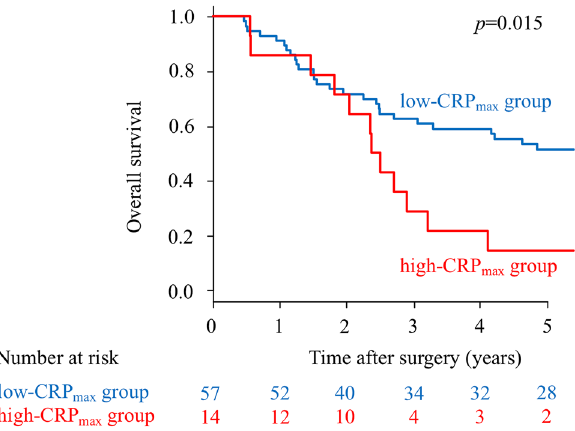
Figure 4. Kaplan–Meier survival curves of overall survival (OS) according to CRP max in patients with postoperative infectious complications ( p = 0.015).